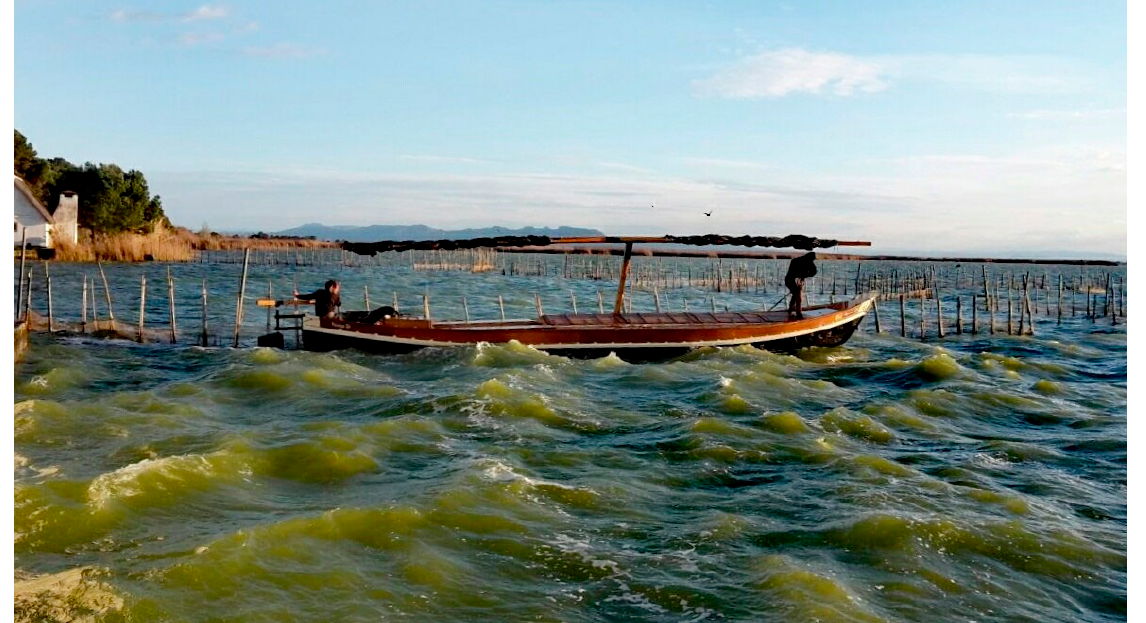
Figure A2. Easterly fresh wind about 30 km h − 1 in Albufera of Valencia. Note greenish water. The 30 cm high waves make the handling of the fishing boat very difficult. Date: 11 April 2018 at 18:30 h. Source: https://www.facebook.com/photo?